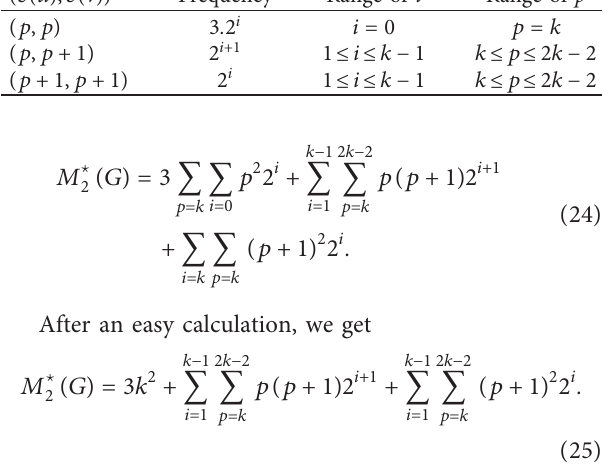
Figure 4: k -level X -tree XT ( k )